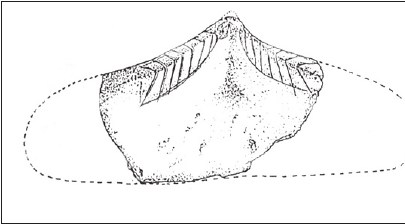
Figure 4. Fragment of three-pointer